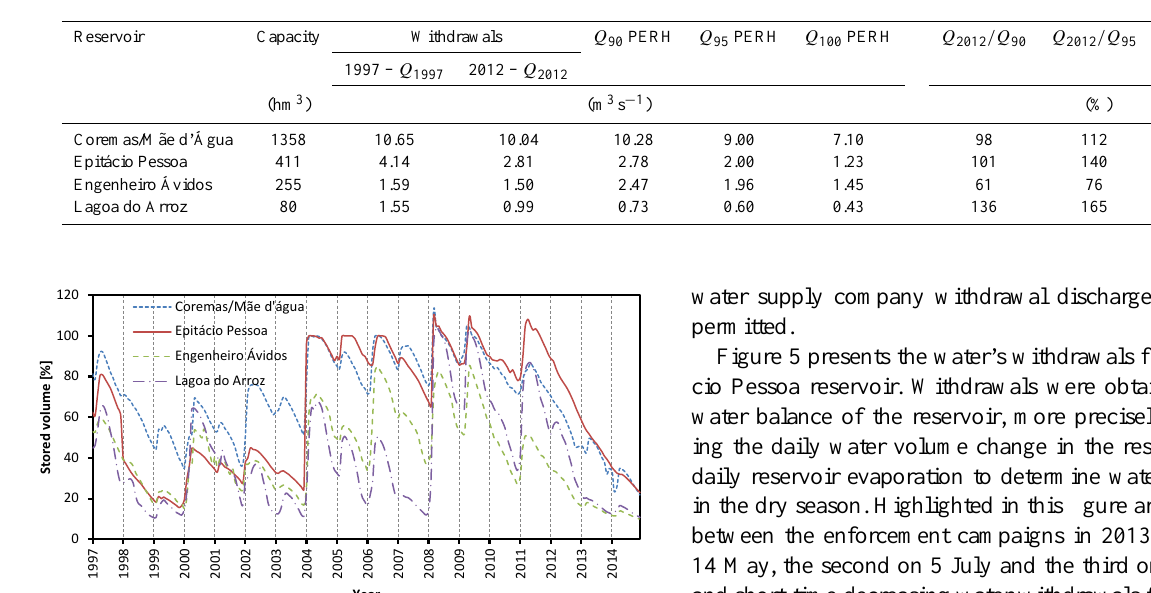
Table 1. Comparisons between reservoir’s withdrawals in 1997 ( Q 1997 ) and 2012 ( Q 2012 ) and reference discharges Q 90 /Q 95 /Q 100 estab- lished by the Paraíba State Water Plan (PERH).